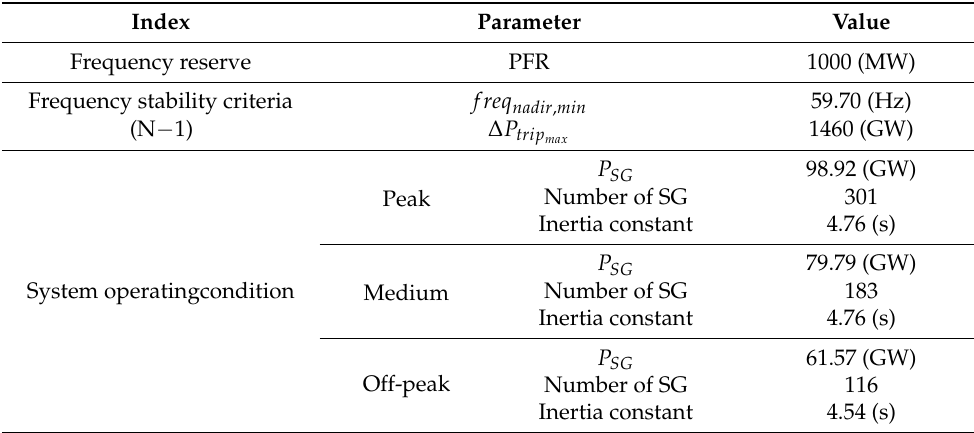
Table 2. Power system operation condition for the